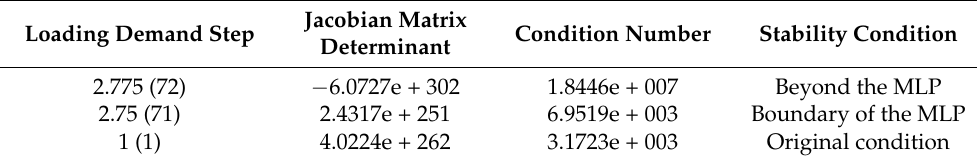
Table 2. The determinant and condition number of the Jacobian matrix at loadings of 2.75 and 2.775. Loading Demand